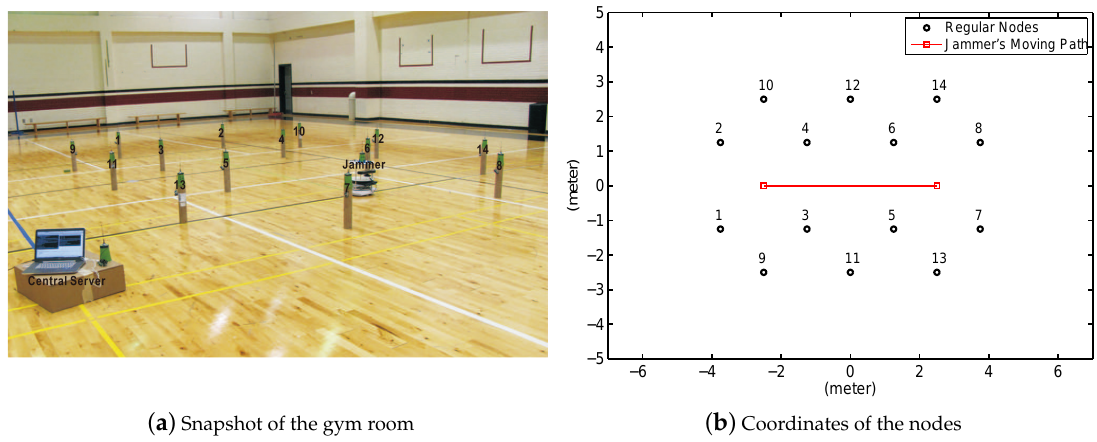
Figure 6. Network deployment in an indoor gym room.